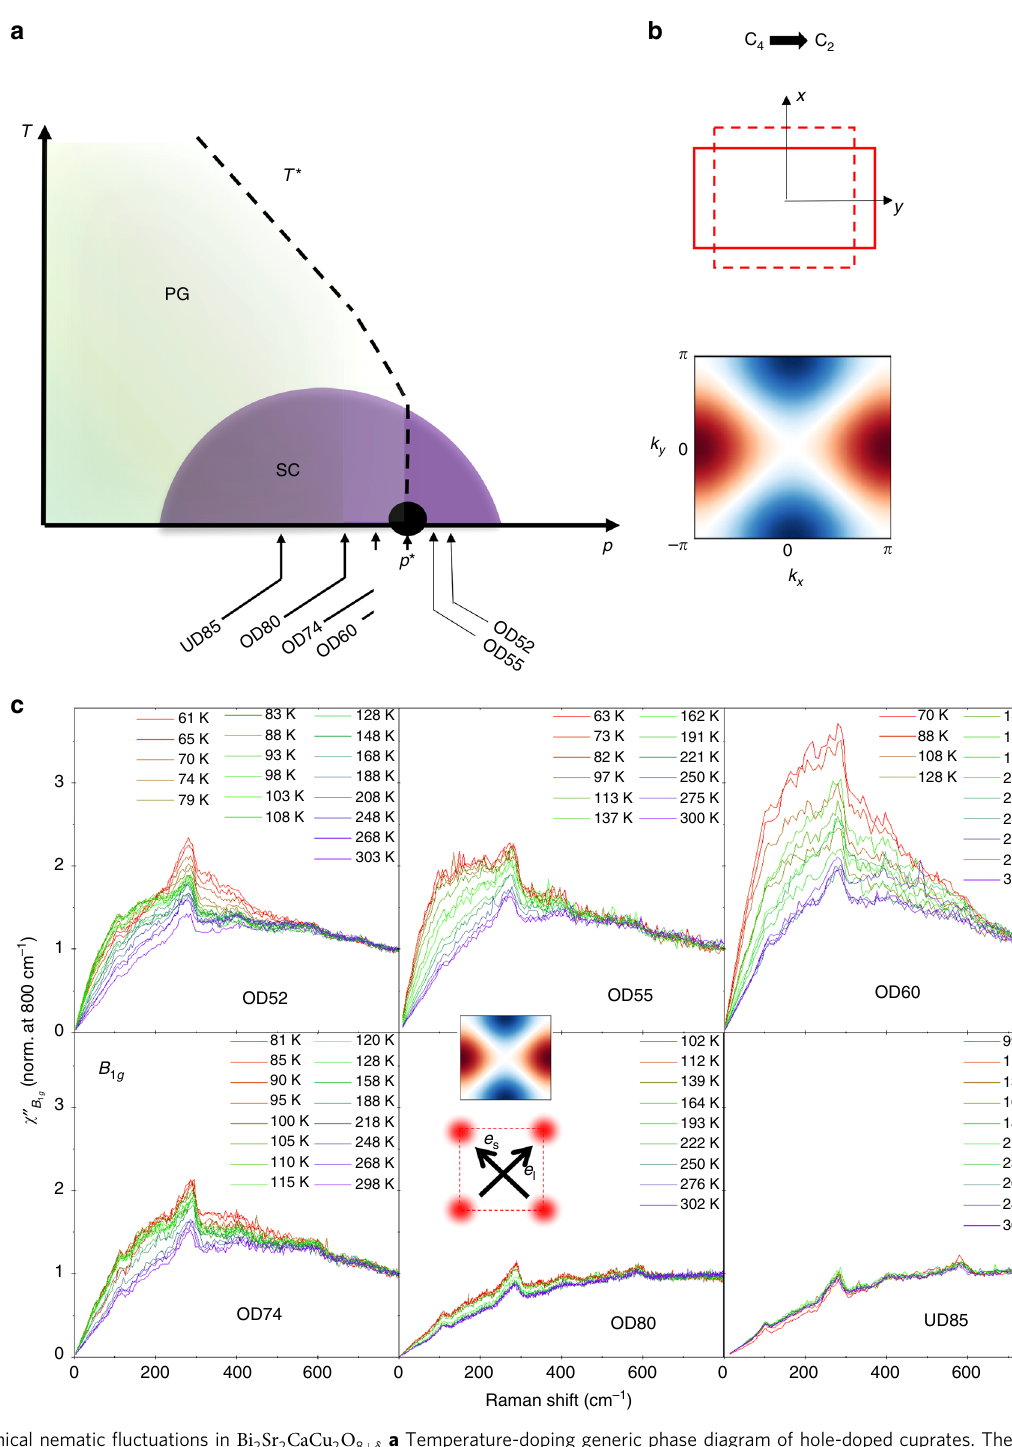
Fig. 1 Dynamical nematic fl uctuations in Bi 2 Sr 2 CaCu 2 O 8 þ δ a Temperature-doping generic phase diagram of hole-doped cuprates. The pseudogap phase ends at a putative quantum critical point (QCP) located at the doping p (cid:2) . b Nematic order breaking the C 4 rotational symmetry of the Cu square lattice down to C 2 symmetry. The corresponding order parameter has B 1 g symmetry: in reciprocal space it transforms as k 2 90 degrees rotation x ! y (color scale is de fi ned as blue: negative values, red: positive values and white: 0). c Temperature dependence of the B 1 g Raman spectrum in the normal state for several doping levels in Bi 2 Sr 2 CaCu 2 O 8 þ δ . The B 1 g symmetry is obtained using cross-photon polarizations at 45 degrees of the Cu – O – Cu direction (see